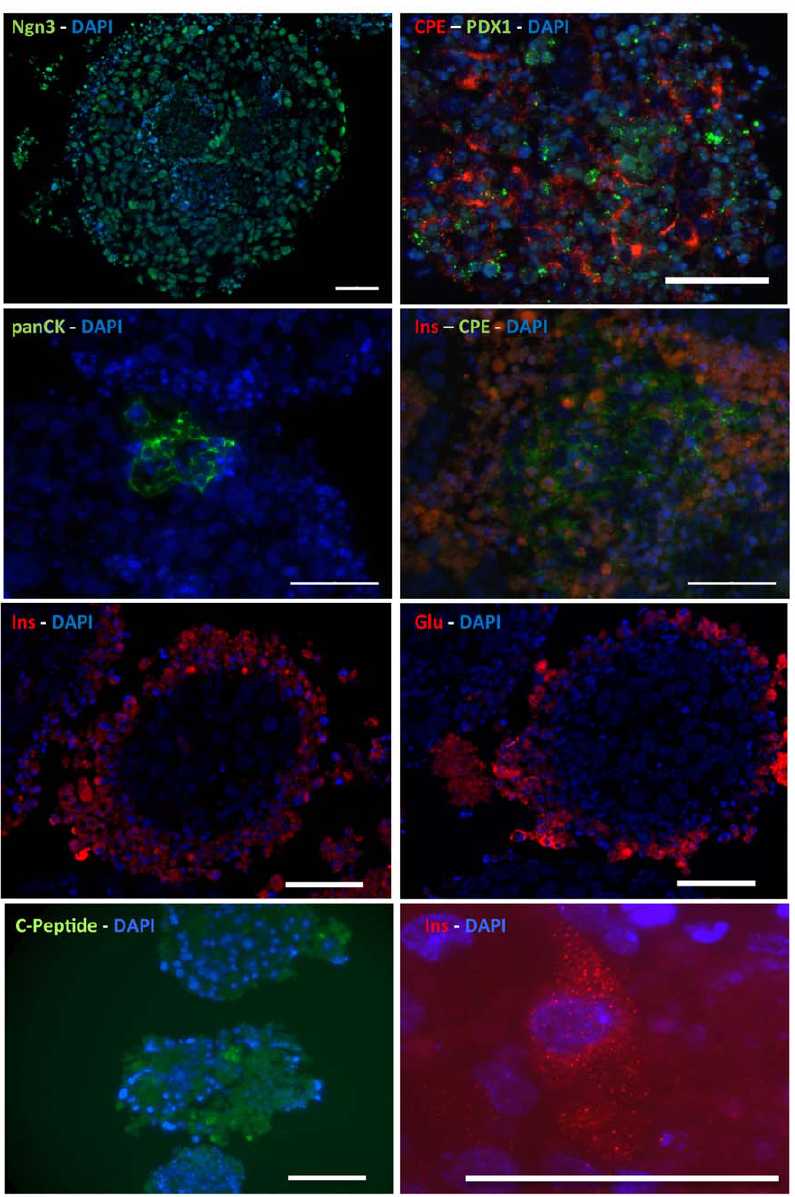
Figure 4. Immunohistochemistry of cell clusters for pancreatic endocrine markers insulin (Ins), C-peptide (CP), carboxypeptidase E (CPE), neurogenin 3 (Ngn3), PDX-1, and glucagon (Glu). Exocrine pancreatic marker pan-cytokeratin (panCK) was also present. The nuclear marker DAPI is included in each figure. Scale bar represents 50 um.